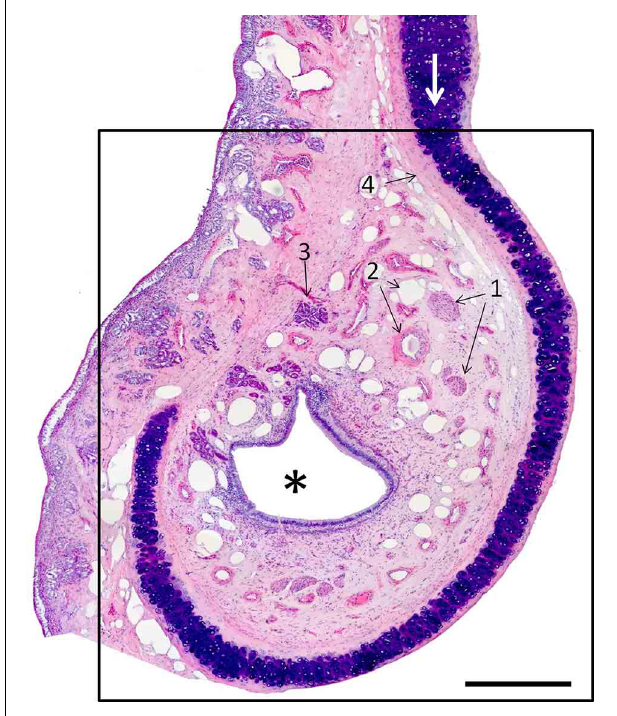
FIGURE 6 | Hematoxylin-eosin-stained transverse section of the vomeronasal organ (VNO, framed); left is lateral, up is dorsal. The asterisk indicates the lumen of the vomeronasal duct; (1) nerves; (2) vessels; and (3) a gland. The VNO is partially surrounded by connective tissue (4) and cartilage (white arrow). Scale bar: 500 μ m (see Figure